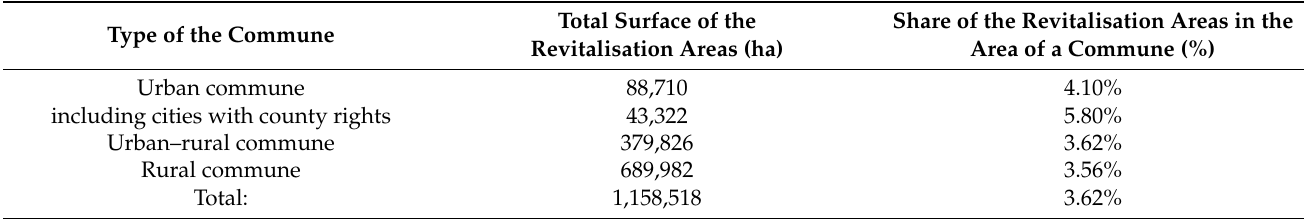
Table 8. Surface of the revitalisation areas by the type of the commune.